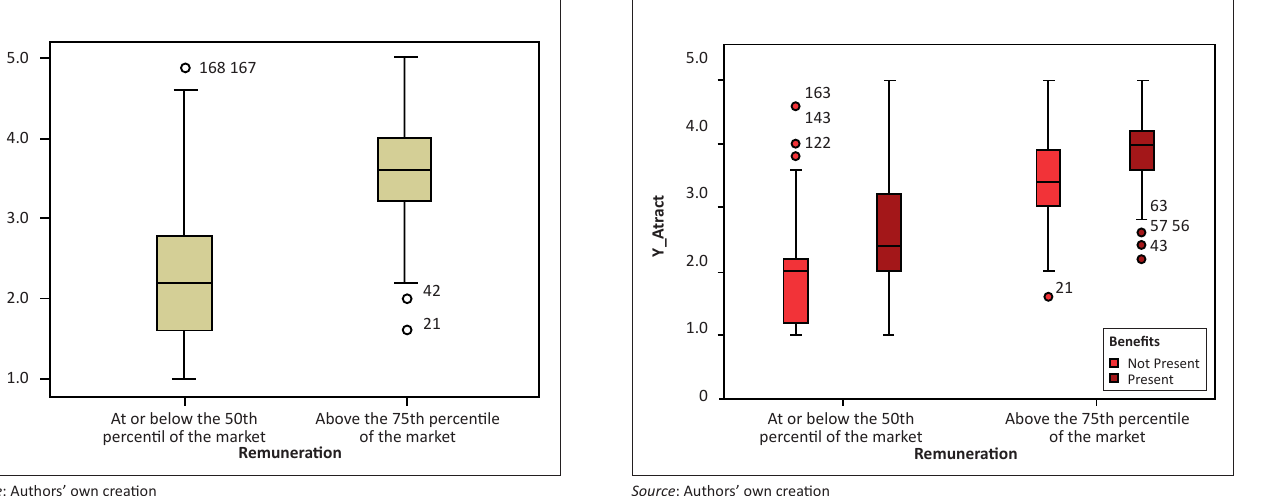
FIGURE 1: Comparison of the means for perceived job attractiveness based on two levels of remuneration.